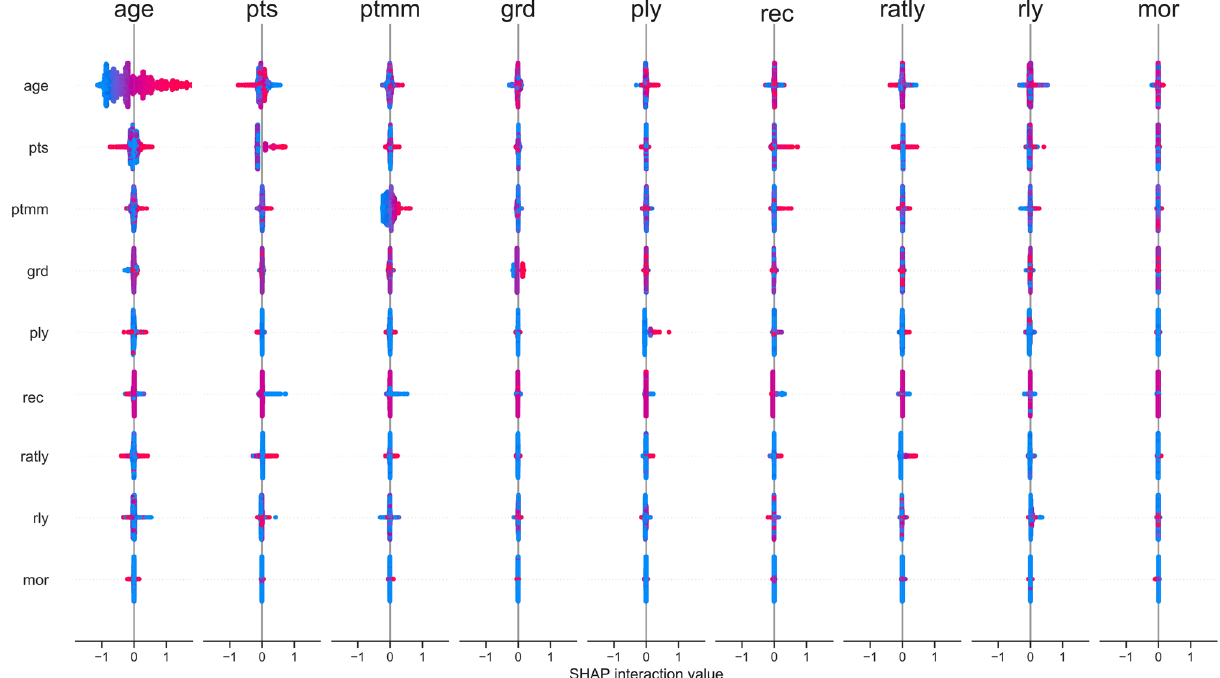
Figure 4. SHAP interaction values. The main effect of each feature is shown in the diagonal, while interaction effects are shown